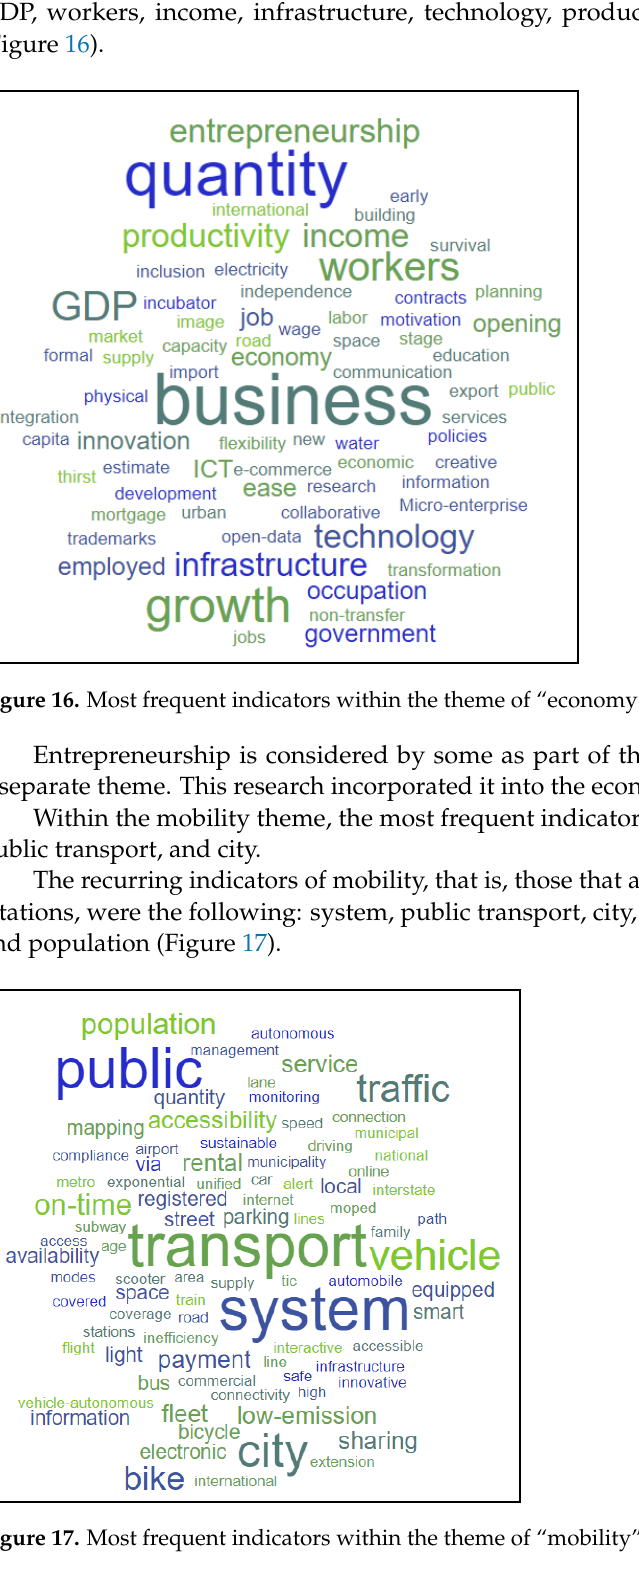
Figure 15. Most frequent indicators within the theme of “environment”.